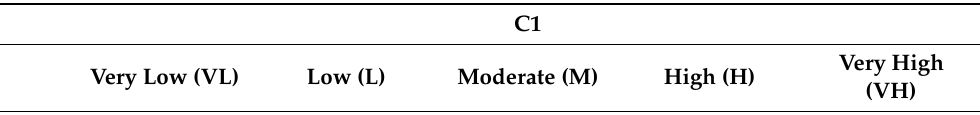
Table A2. Questionnaire used to know the decision makers’ preferences for the 13 alternatives according to the criteria.